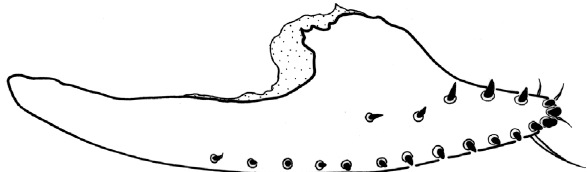
Figure 25. Left oviscapt valve of the female paratype of Drosophila montevidensis sp. nov. : outer lateral view. Scale bar: 0.1